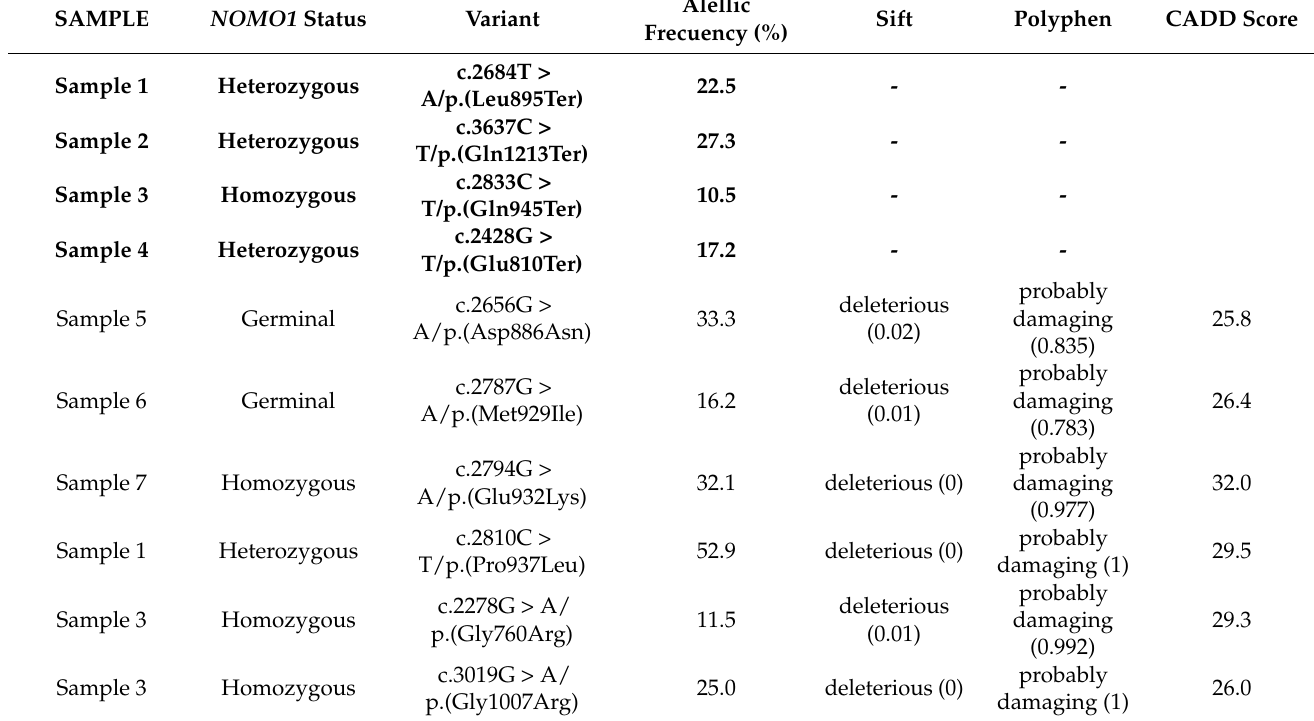
Table 2. Pathogenic mutations and variants of uncertain significance (VUS) identified in EOCRC tumors. Classification of VUS by different prediction programs is shown: Sift (scores ≤ 0.05 are called “deleterious”, and scores > 0.05 are called “tolerated”), Polyphen (scores > 0.446 are called “probably damaging”, and scores ≤ 0.446 are called “benign”), and CADD (scores > 30 are called “likely delete- rious”, and scores ≤ 30 are called “likely benign”). The text in bold indicates pathogenic